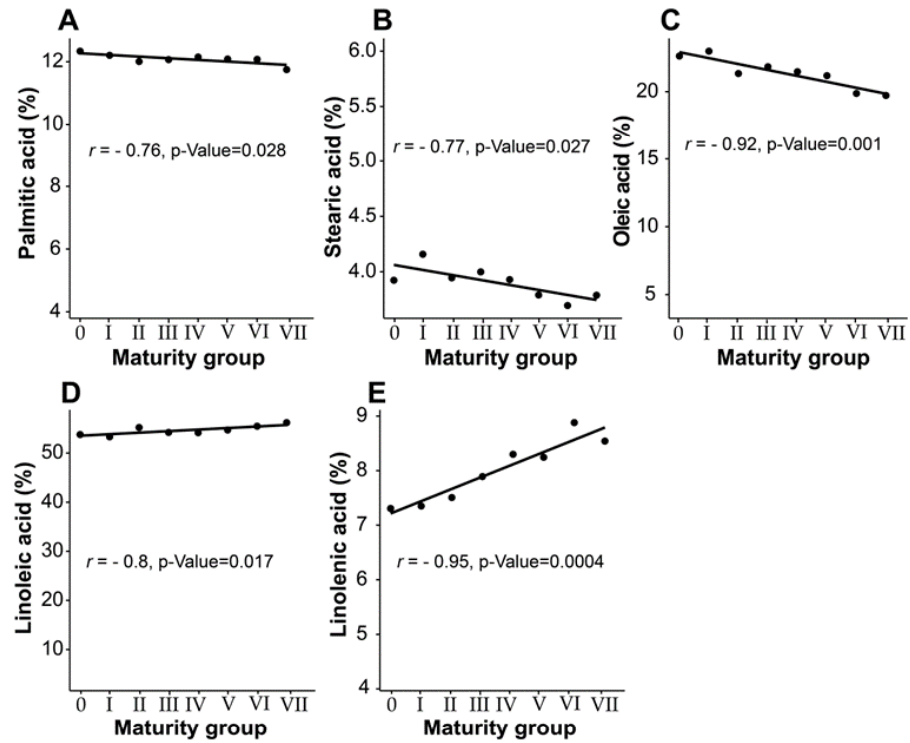
Figure 2. Relationship between means of soybean seed five fatty acid composition (%) with maturity groups (MG0–VII). ( A ) palmitic acid, ( B ) stearic acid, ( C ) oleic acid, ( D ) linoleic acid, and ( E ) linolenic acid.